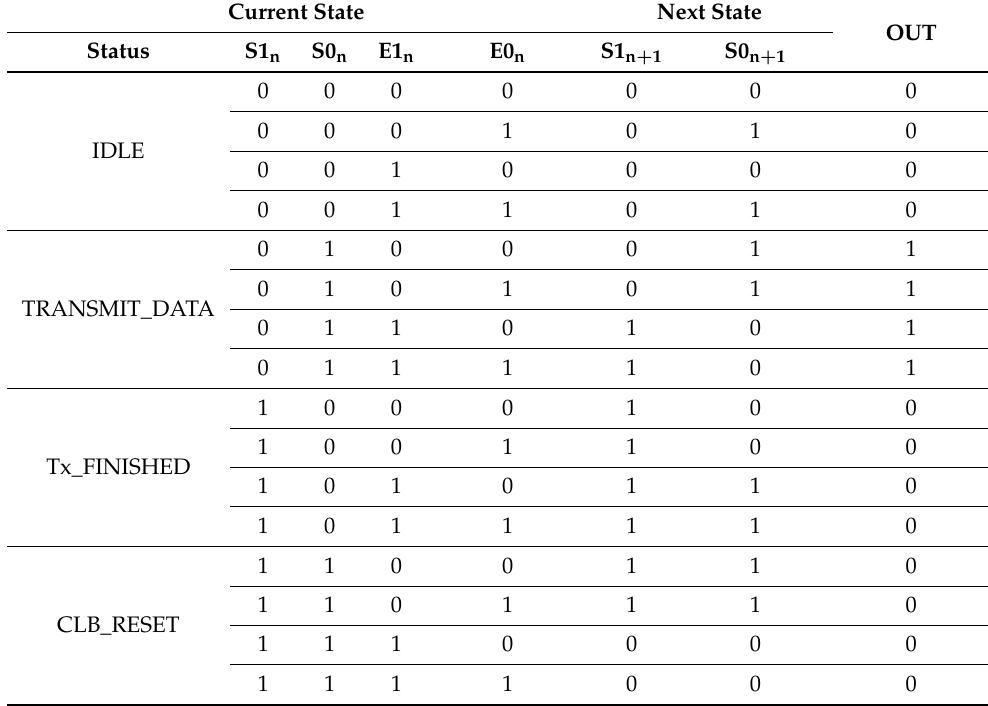
Table 2. State table of